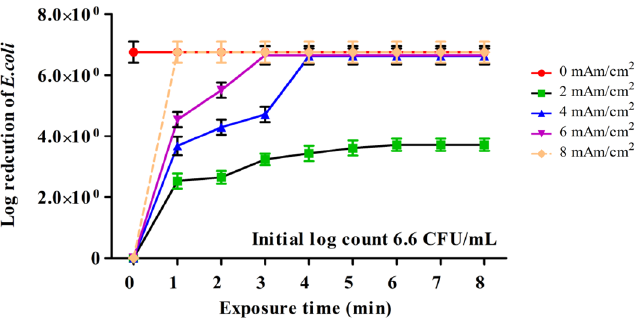
Figure 3. Effect of different current densities (2–8 mAm/cm 2 ) on E. coli bacterial inactivation during electrochemical inactivation treatment of solutions containing initial concentration of ∼ 10 6 CFU/mL E. coli . Experimental data are shown as mean value ± standard deviation (n = 3).